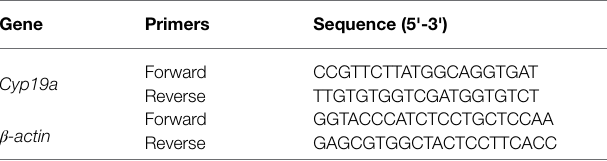
TABLE 2 | List of forward and reverse primers for qPCR analysis in